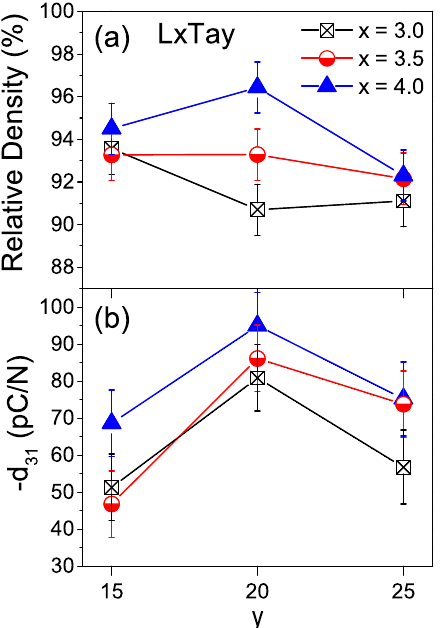
Figure 8. Composition dependence of ( a ) the relative density and ( b ) the piezoelectric coefficient d 31 at 25 ◦ C for the LKNNT ceramics, sintered at 1110 ◦ C for 2